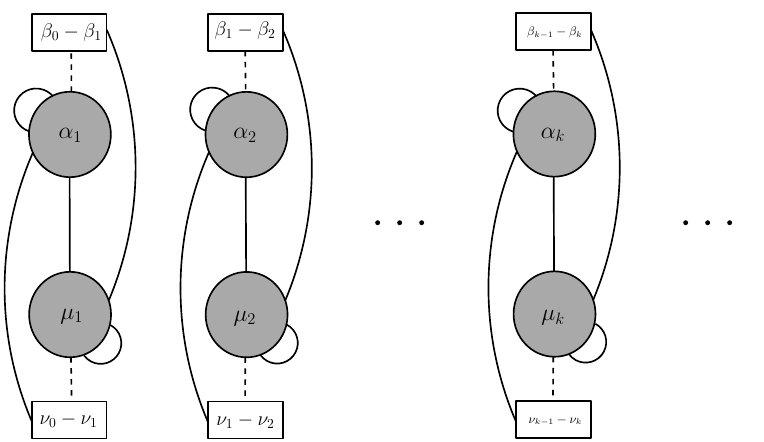
Figure 2 . The proposed quantum mechanical quiver. This follows from the analysis of open strings in the Hanany-Witten